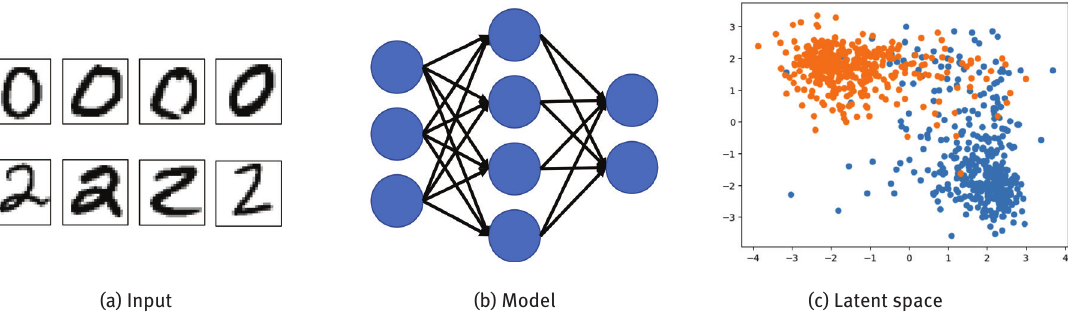
Figure 2: The raw input data (a) are transformed by the model (b) into two separate clusters in the network’s represen- tation or latent space (c). Those points that are far away from the cluster centers correspond to images that have been presented to the model at an early stage in the learning process, where the model has not yet managed to build its internal categories.